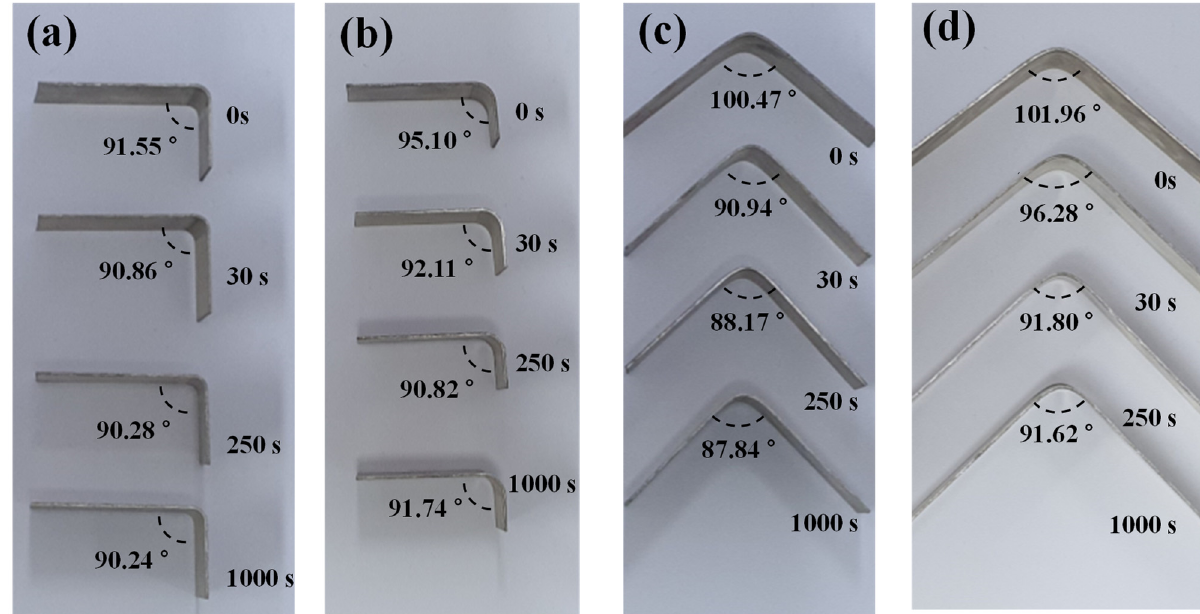
Figure 18. Deformed geometry after springback at 250 °C with various holding times in the die set; ( a ) L-bending with the die radius of 4 mm; ( b ) L-bending with the die radius of 6 mm; ( c ) V-bending with the punch radius of 1 mm; ( d ) V-bending with the punch radius of 6 mm.